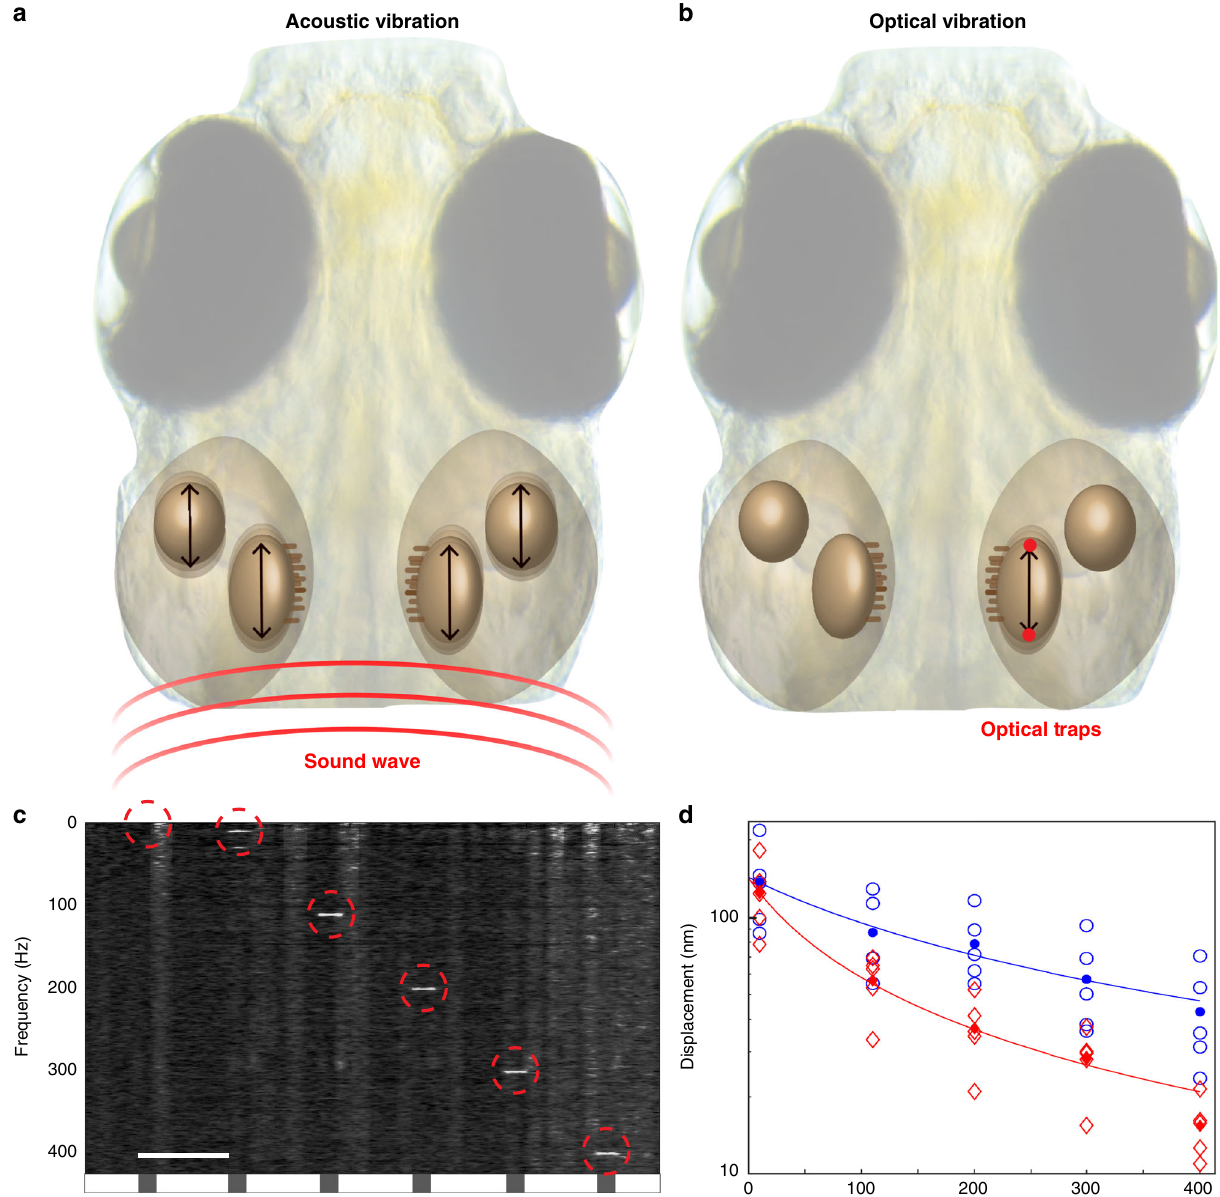
Fig. 2 Mechanics of sound perception in zebra fi sh. a Schematic illustration of sound propagation from a speaker and the resulting movements of the otoliths in larval zebra fi sh ear. b Illustration of OT targeted to alternating sides of one otolith at high speed, and the resulting selective vibration of the targeted otolith. c Average spectrogram (normalized over frequency) of the position of the optically manipulated otoliths (both saccule and utricle combined) over time across 5 fi sh. Gray boxes on the timeline represent 1 s of OT stimulation. The number written under the box represents the OT frequency of the stimulation. See Supplementary Figs. 2 and 3 for more details on the movements of each type of otolith. Scale bar in c is 5 s. Diffuse vertical bands are artefacts produced by animal movements, and movements of the otolith at 1 Hz stimulation are masked by background movements. d Individual measurements of otolith displacements at different frequencies of BOA stimulation (empty circles and diamonds), displayed on a logarithmic scale. Saccule data are represented in blue and utricle in red. Filled circles and diamonds represent mean values. Fit was performed to Eq. (1), with fi tting parameters describing γ and k and neglecting mass. N = 5 fi